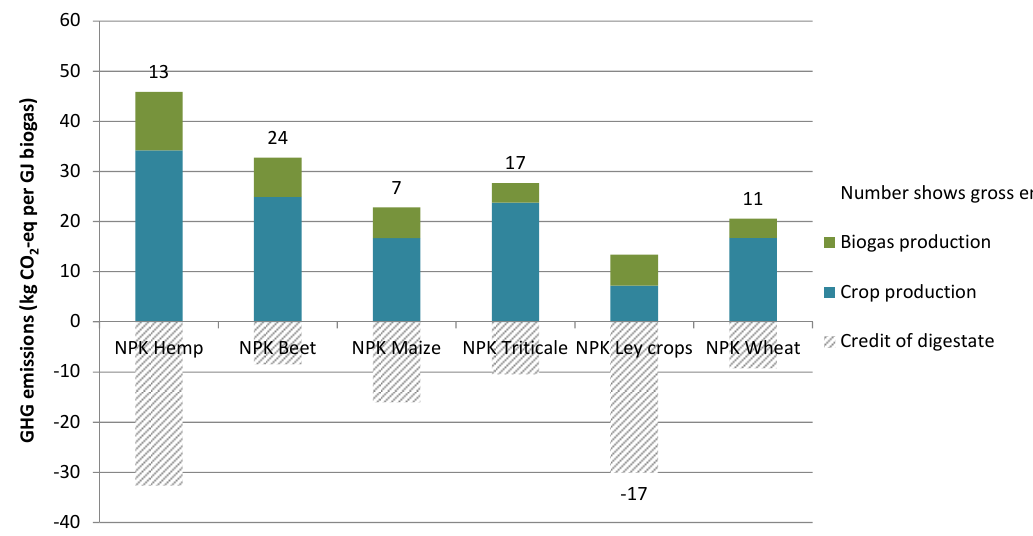
Figure 4. GHG performance of the various crop-based biogas production systems (expressed as kg CO 2 -eq·GJ − 1 biogas) for the cultivation systems including only mineral fertiliser (NPK). The credit of digestate is shown as negative bars and the numbers above the bars show the net GHG performance including this credit (credit of increased SOC content from the crop cultivation is already included in “Crop production”). Based on Tables 2, 4 and